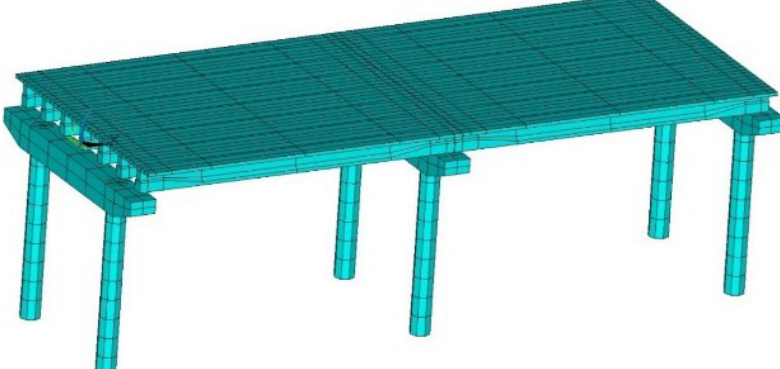
Figure 15. Bridge prototype.